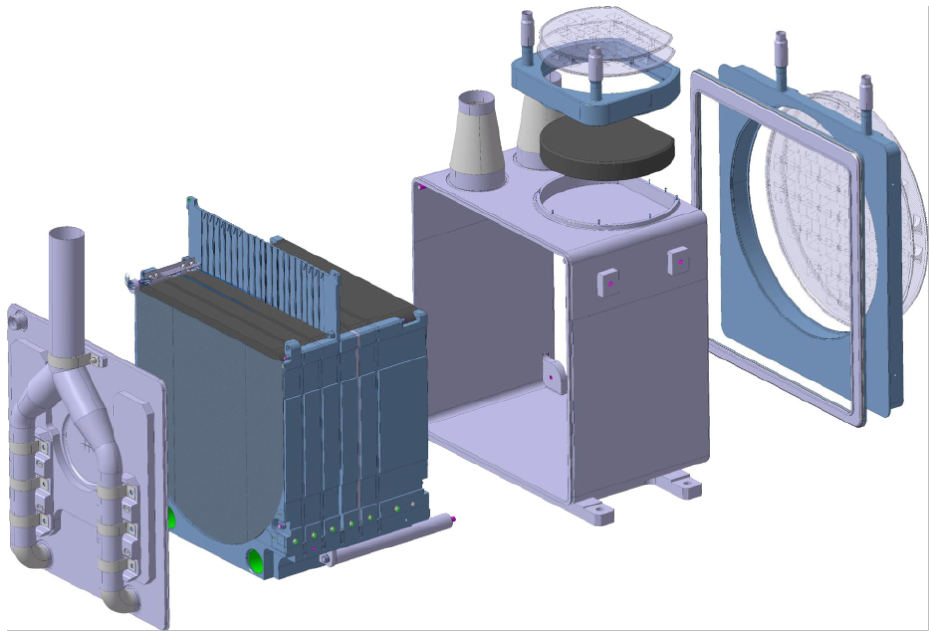
Figure 2. Exploded model of the target. The cooling nitrogen gas flows through the channels machined into the anticreep plates. The inner core is enclosed in an AISI 316L stainless steel vessel (figure from ref.